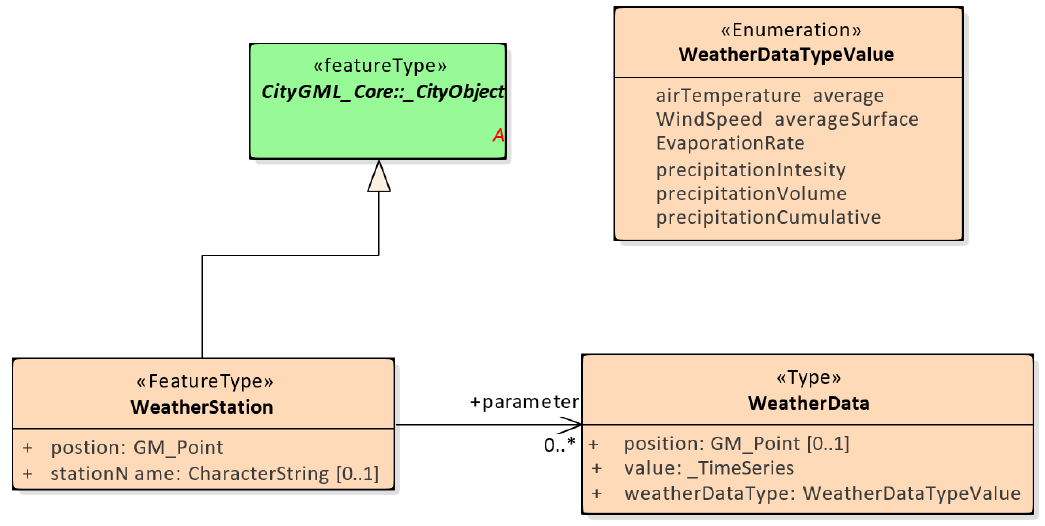
Figure 8. UML class diagram of Weather.